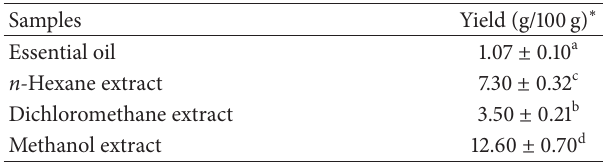
Table 1: Yield of M. longifolia essential oil and hexane, dichloro- methane, and methanol